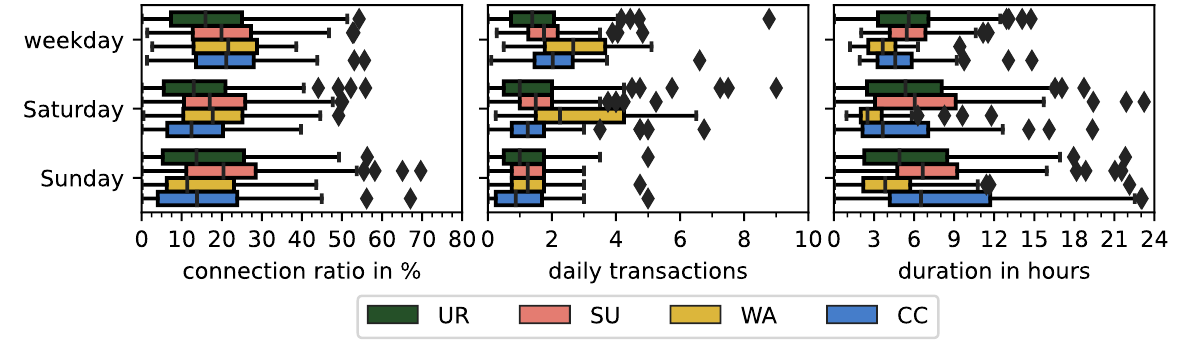
Figure 11. Usage indicators per